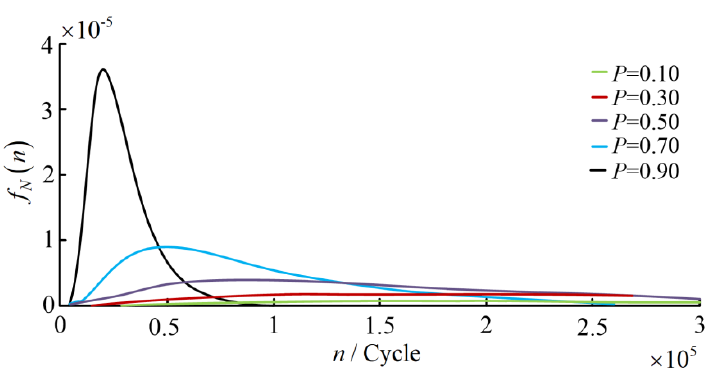
Figure 5. Fatigue life distribution affected by parameters of material.